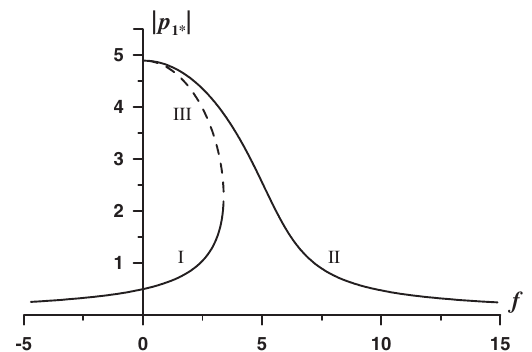
FIG. 2. The absolute value of electron transverse momentum p ?(cid:8) at the equilibrium helical trajectory as a function of guide magnetic field strength f ( (cid:3) ¼ 5 , (cid:4)